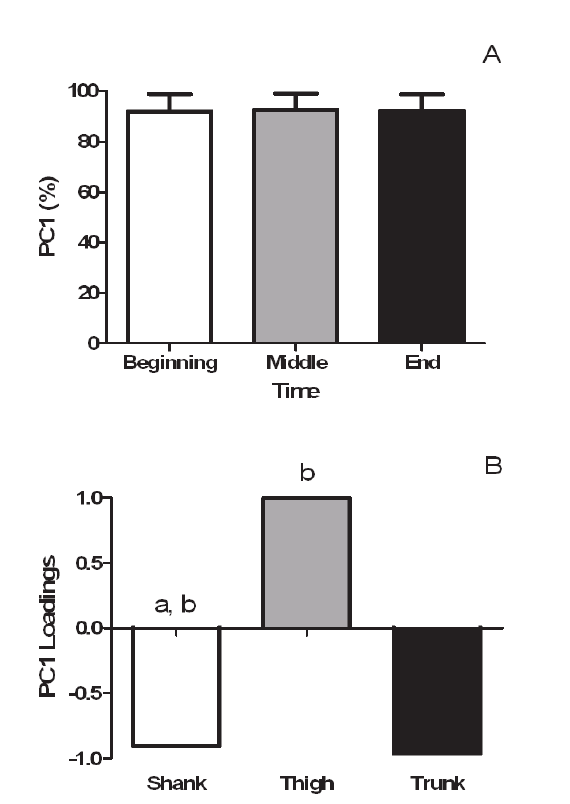
Figure 4. Segment angle at movement reversal in different time of shank (A), thigh (B) and trunk (C). a different from the end (p < .001); b different from the middle ( p <